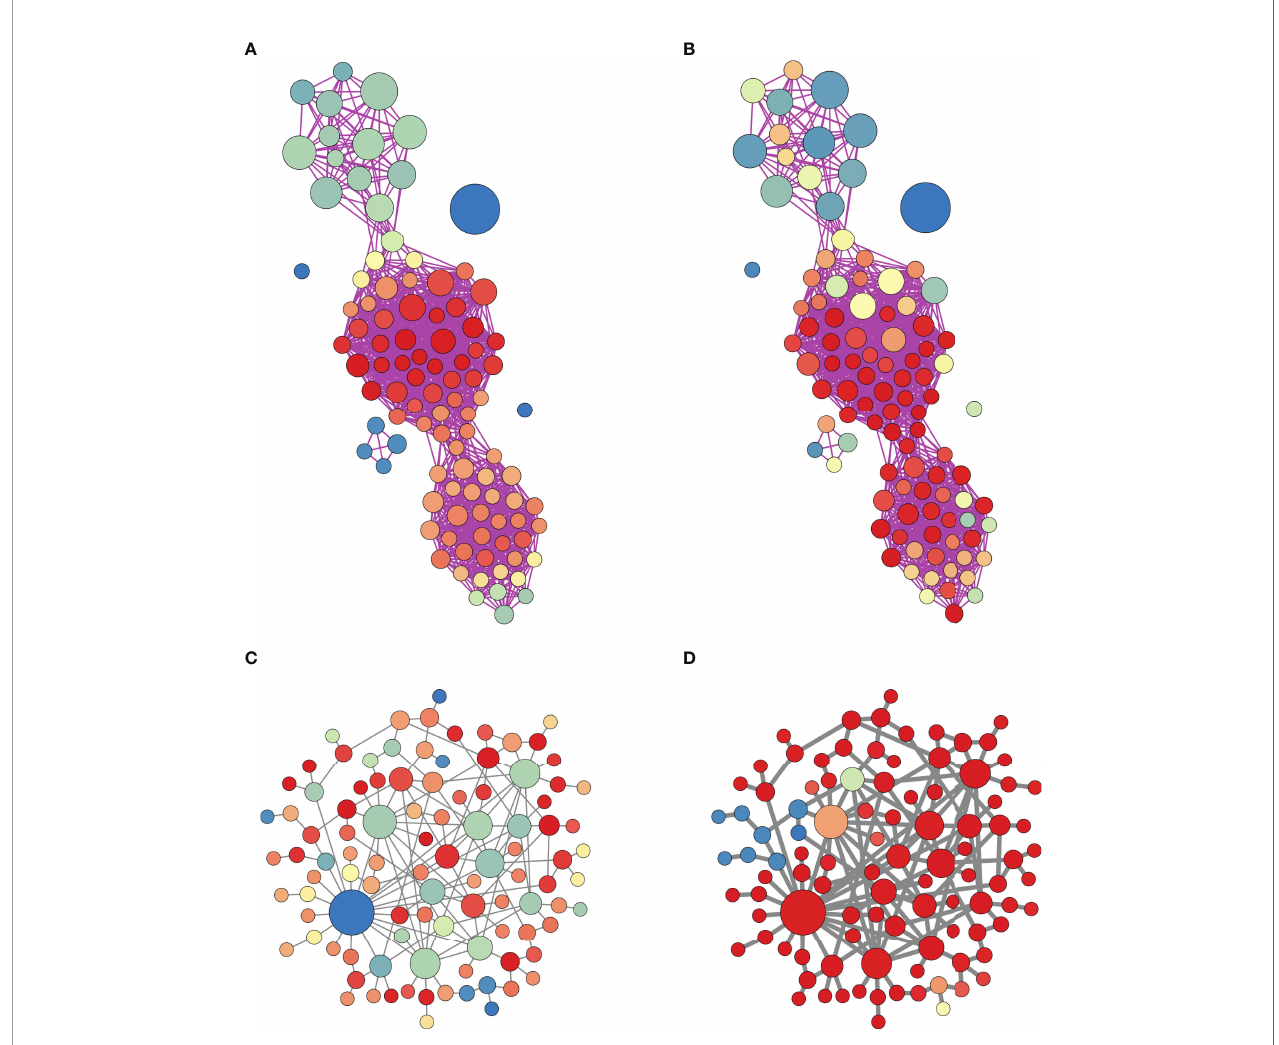
FIGURE 13 | Hybrid structural-functional network representations of the scale-free network of Figure 9 . In all panels, the node size represents its degree in the structural network. (A) The edges represent functional coupling (synchronization) between nodes, where S ij >0.85 is required for coupling between nodes i and j . The color of a node indicates functional degree, i.e., the number of nodes it synchronizes with. Hotter colors indicate higher degree. (B) The edges again represent functional coupling, but now the color of a node indicates its closeness centrality in the structural network. Hotter colors indicates higher centrality. (C) The edges now represent structural connectivity in the same network (but displayed differently to emphasize structure instead of function). The node color represents functional degree. (D) When the strength of coupling is increased by a factor of 5 to g c =10 pS (thicker edges), the network becomes much more